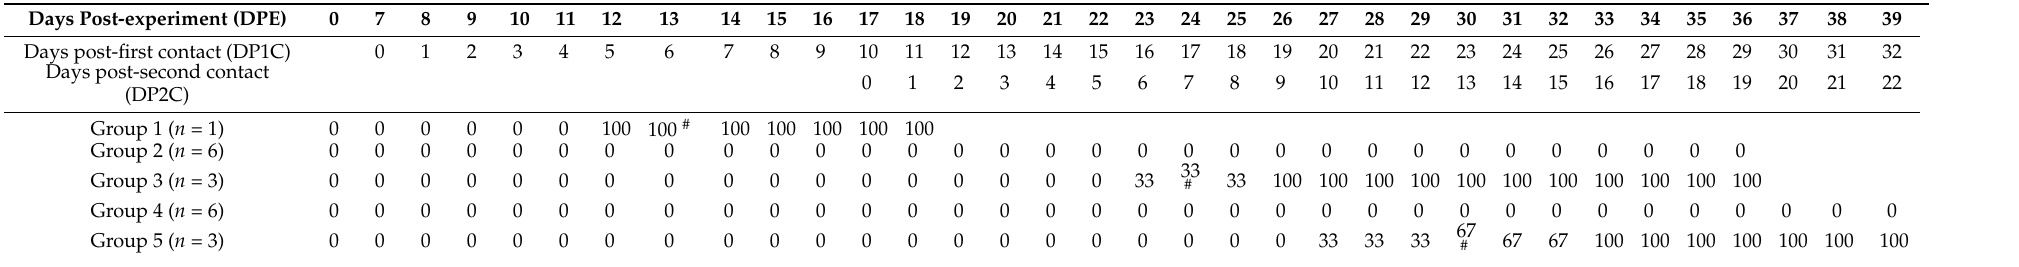
Table 1. Percentage of febrile piglets in each group during the experimental